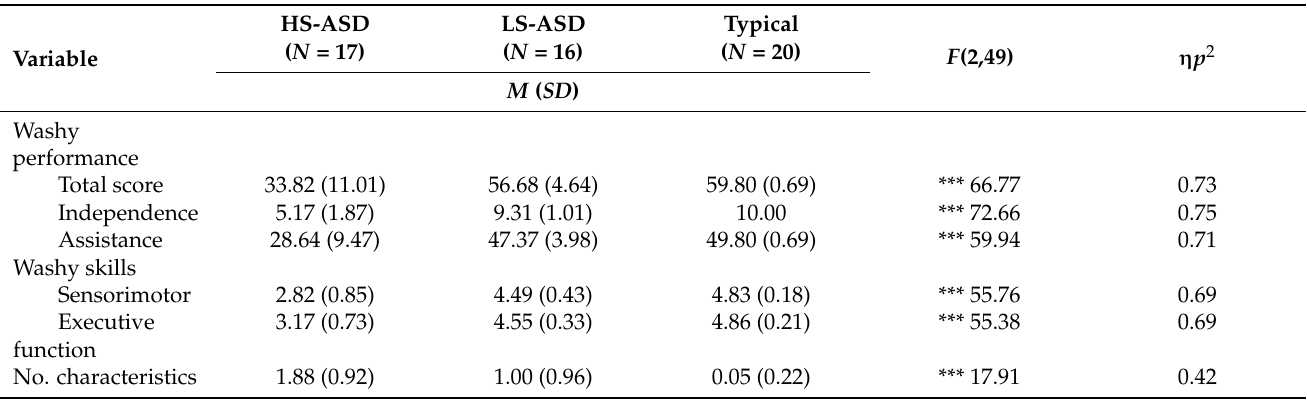
Table 2. Washing Hands Structured Observation (Washy) scores: averages, standard deviations, and F